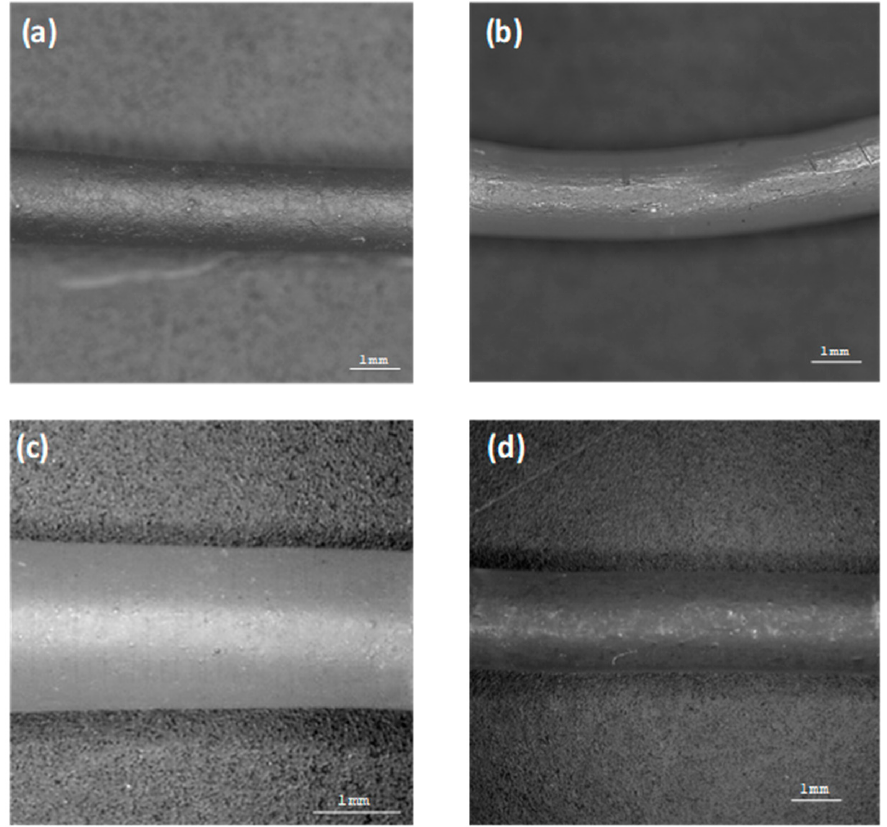
Figure 3. Scanning electron microscopy (SEM) pictures of extruded filaments: ( a ) F1, ( b ) F2, ( c ) F3, and ( d ) F4.